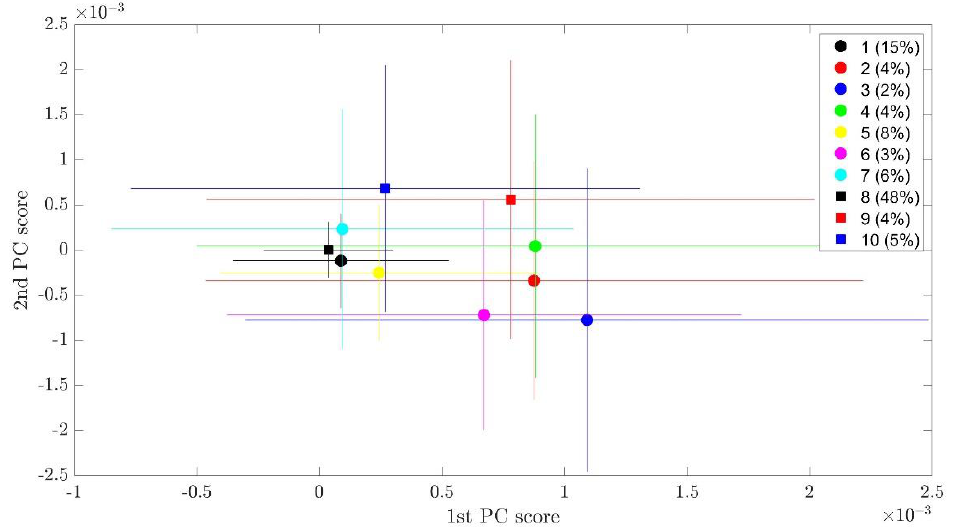
Figure 9. Centroids and spreading of scores for all the six clusters obtained. The coloured circle represents the centroid of the cluster, and the solid vertical and horizontal lines represent twice the standard deviation of each PC. The percentage of profiles belonging to each cluster is shown in parentheses in the legend together with the cluster number.